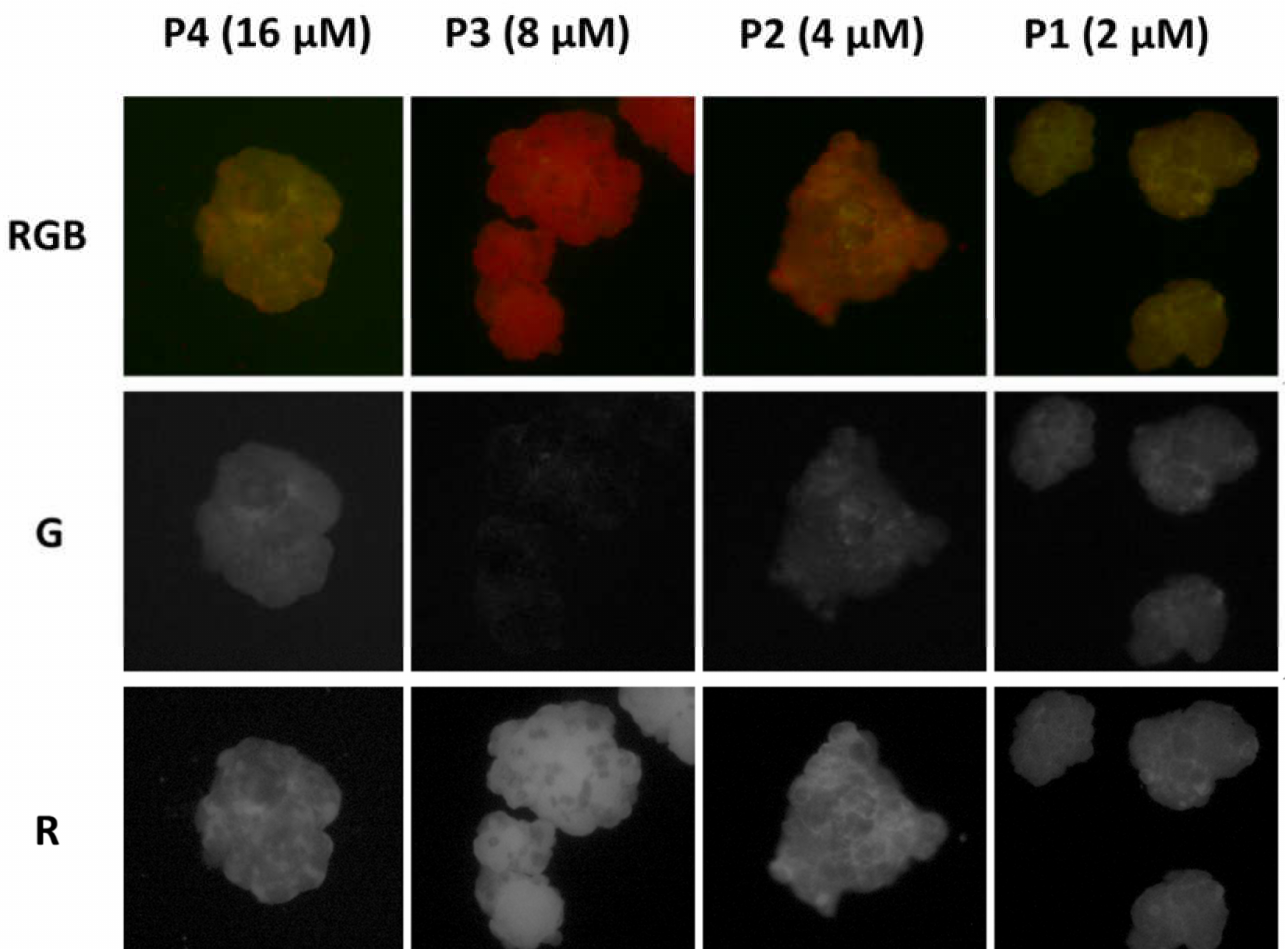
Figure 5. ( Top ) RGB color images of PVC particles after 2 h incubation with P in buffered water solution (pH = 7) at decreasing concentration (16, 8, 4 and 2 µ M, solutions P4-P1) obtained with a fluorescence inverted microscope upon illumination with a blue LED diode in epifluorescence mode. The images were acquired with a conventional CMOS camera directly in the P solutions, without any washing. The later size of each image is 450 µ m. The images were split into the three color components R, G and B with the software Image J. The G components are shown in the second line of images. The R component are shown at the ( bottom